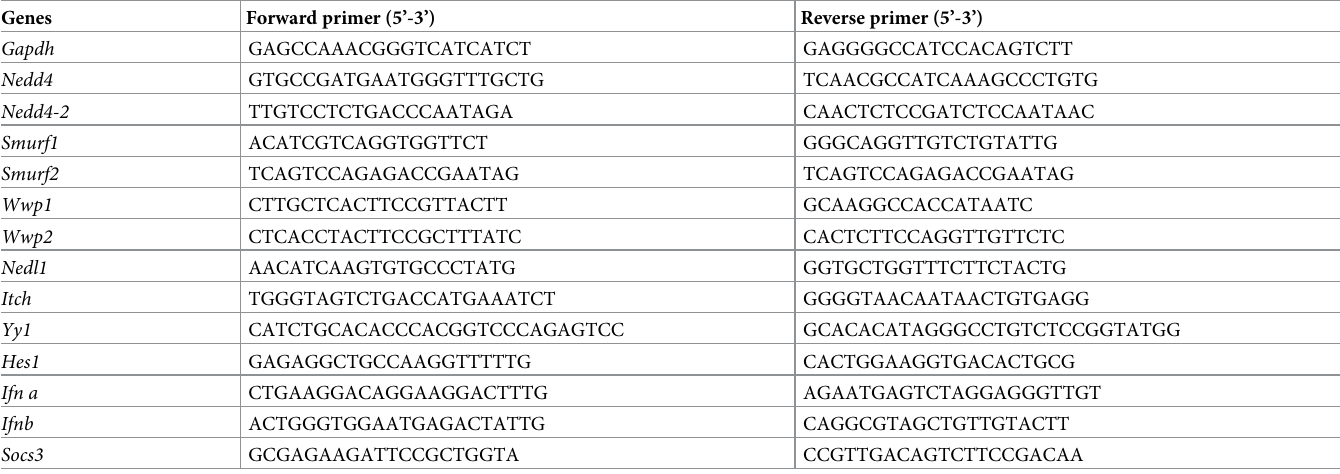
Table 1. Primer sets used for gene expression